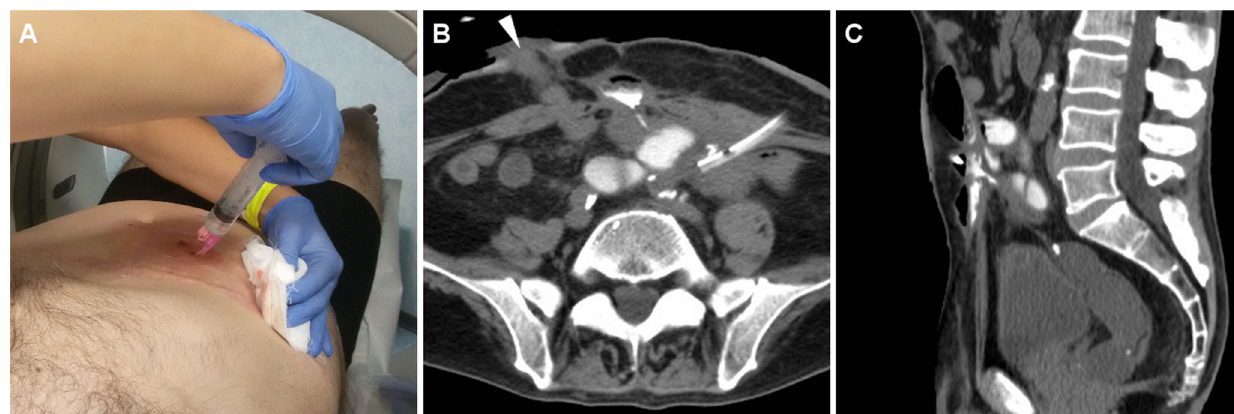
hemicolectomy and repeated surgery for complications: shortly after ileostomy closure (note drainage tube) low-output ECF was diagnosed, withcommunicationbetween theEFO (arrowhead in B ) andthe opacified